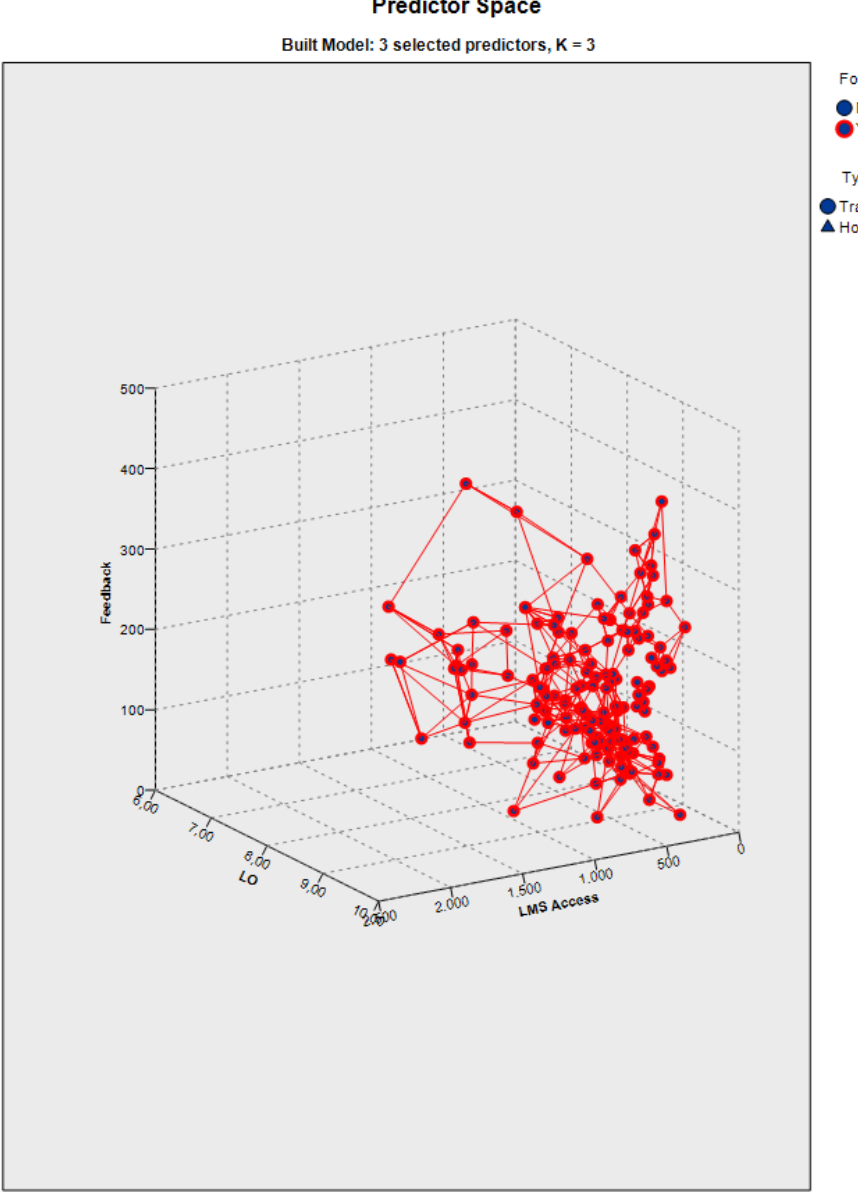
Figure 3. k- nn considering as focal variables the group type (ALT resource combination) and feature selection.